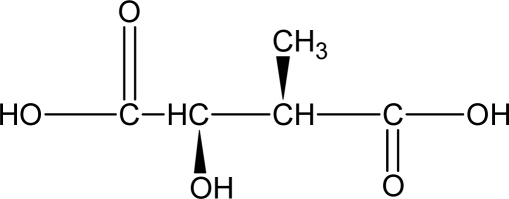
Structure of L-tartaric acid; (2R,3R)-(+)-2,3-dihydroxybutanedioic acid.